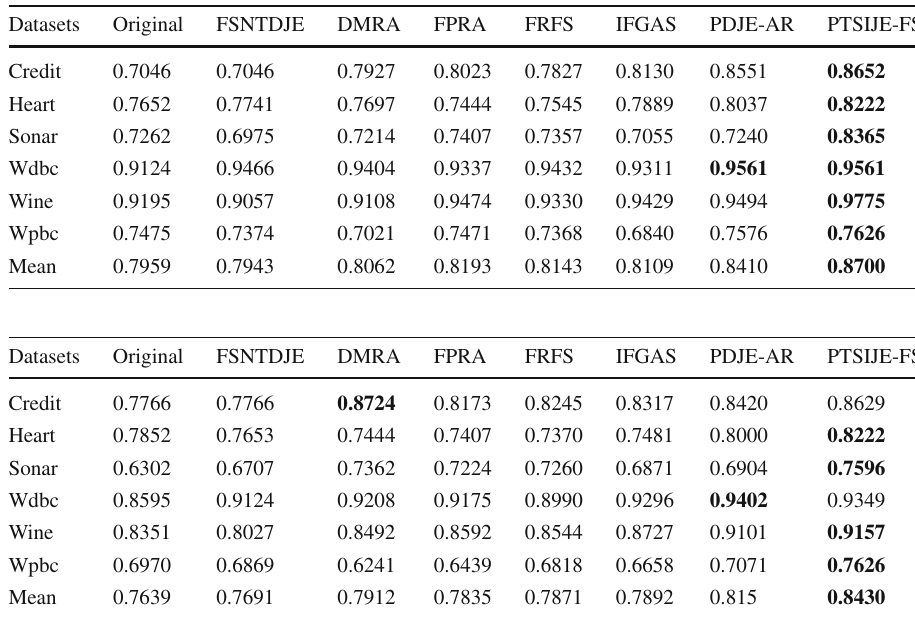
Table 5 Classification accuracy of the seven methods under the KNN classifier